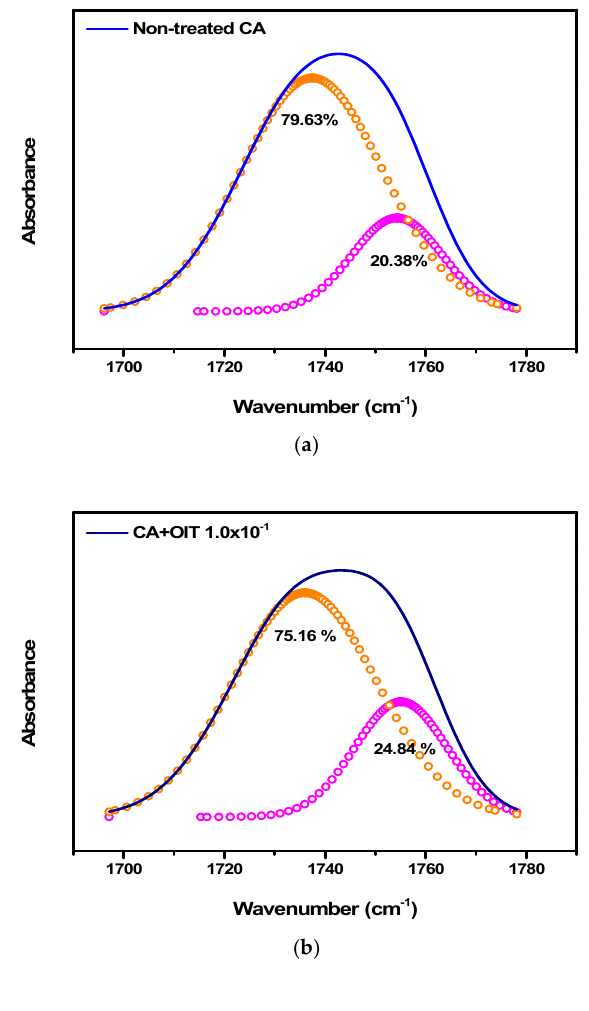
Figure 5. FT-IR spectra for the interaction between the carbonyl groups of the cellulose acetate (CA) polymers with 2-n-octyl-4-isothiazolin-3-one (OIT) at various concentrations.